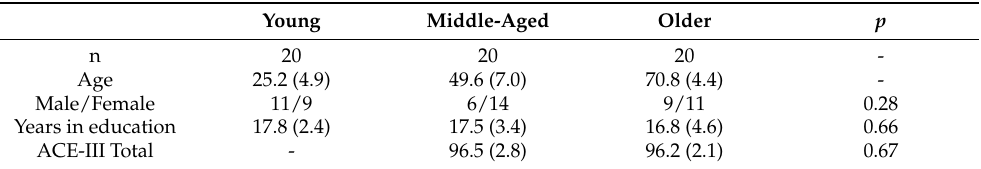
Table 1. Descriptive information. ACE-III = Addenbrooke’s Cognitive Examination III. Age, years in education and ACE-III scores are presented as mean